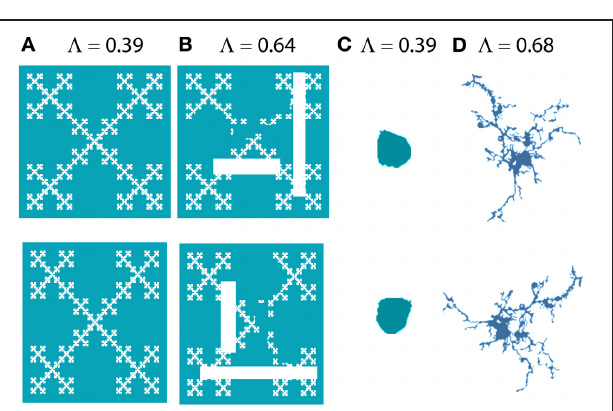
FIGURE 4 | Lacunarity. The images on the bottom row are 90 ◦ rotations of the images on the top row. Images (A) and (C) look similar to their originals when rotated, but (B) and (D) are more affected by rotation; they are more heterogeneous or less rotationally invariant and this is captured and quantified by (cid:2) [e.g., (B) has greater lacunarity than (A) ]. (A) and (B) were generated with ImageJ fractal generator plugin http://imagej.nih.gov/ij/ plugins/fractal-generator.html; (C) and (D) are from Figure 1